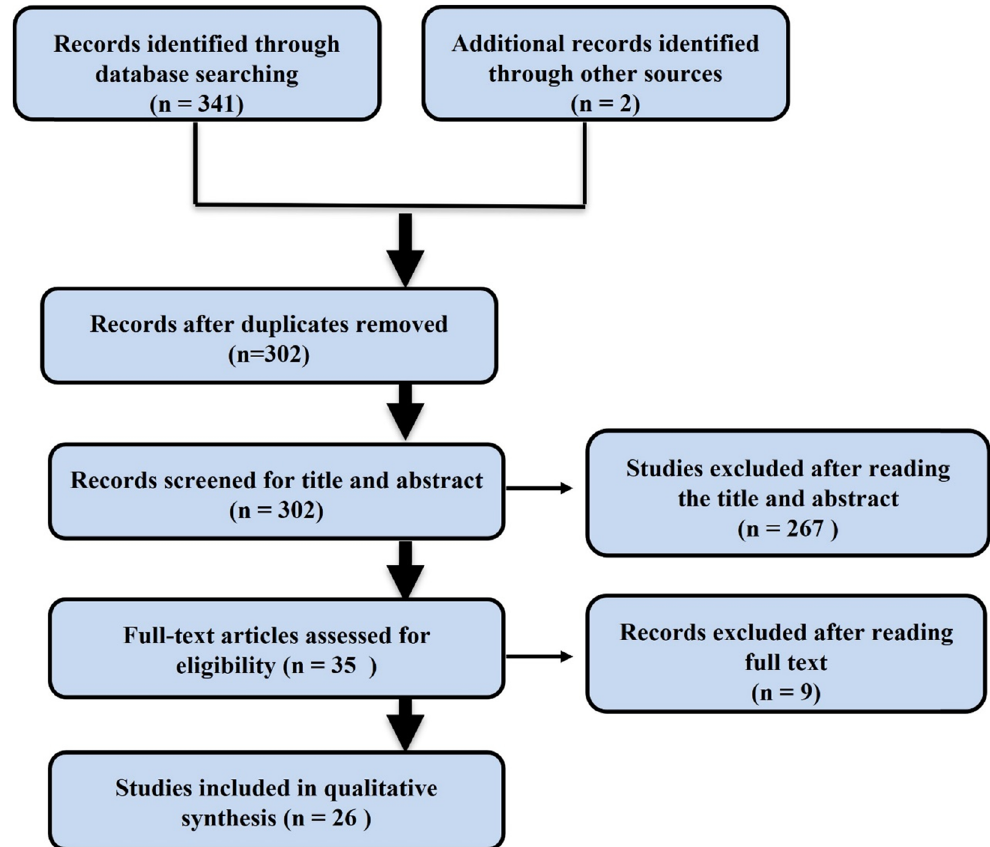
Figure 1: The electronic searching of publications and studies inclusion fl ow -